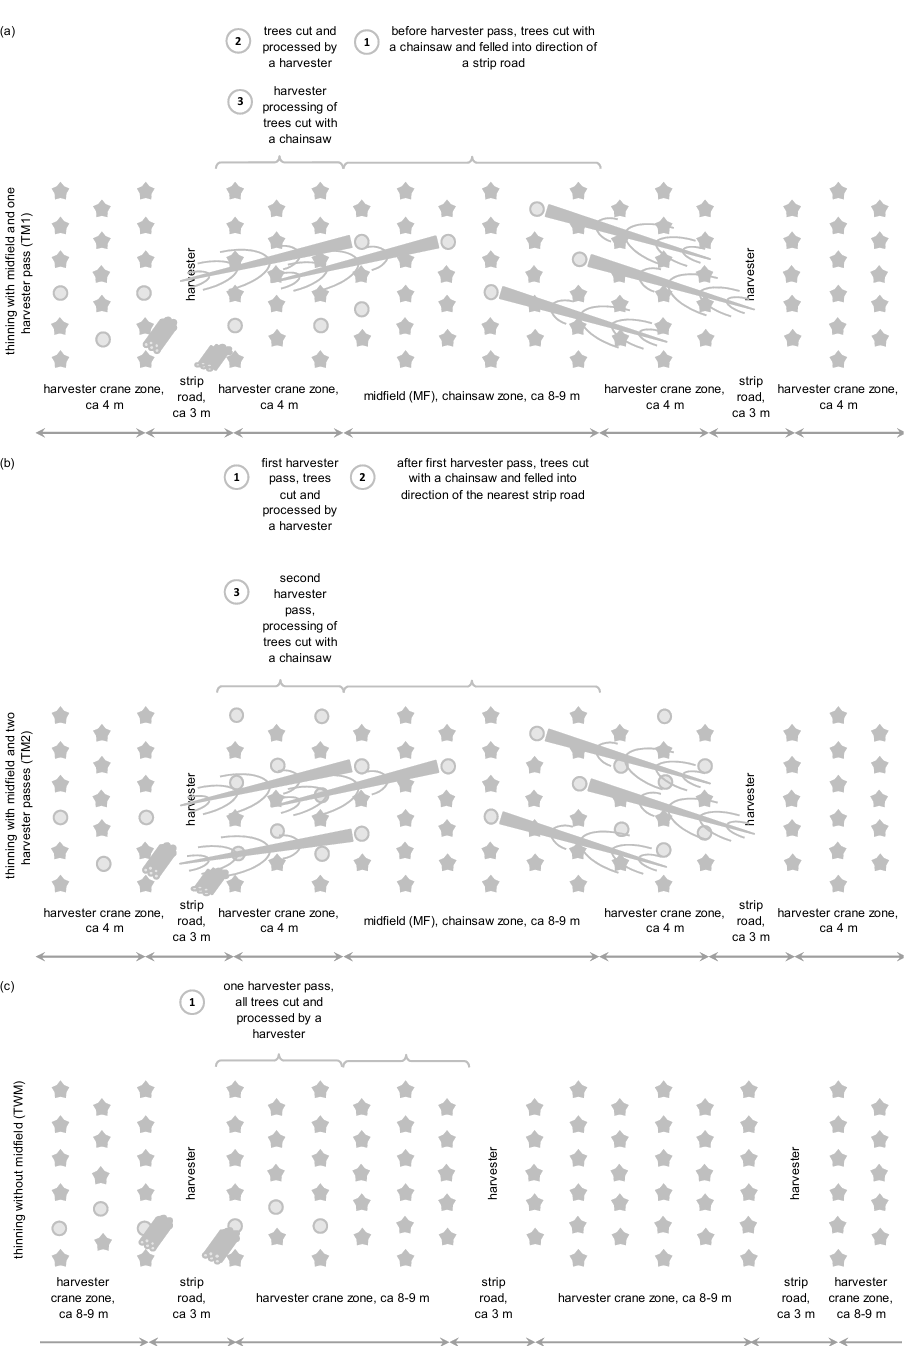
Figure 1. Design of analysed thinning operations: ( a ) Thinning with midfield and one harvester pass (TM1); ( b ) Thinning with midfield and two harvester passes (TM2); ( c ) Thinning without midfield (TWM). Distance between tree rows was from 1.4 to 1.6 m.